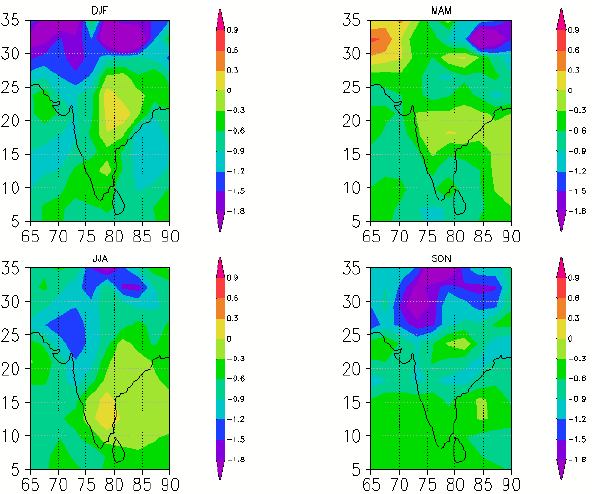
Figure 9. Ten-year seasonal 2m temperature anomalies (in K) in the MAIN_MLO simulation with GAINS emissions and without aerosol activation.